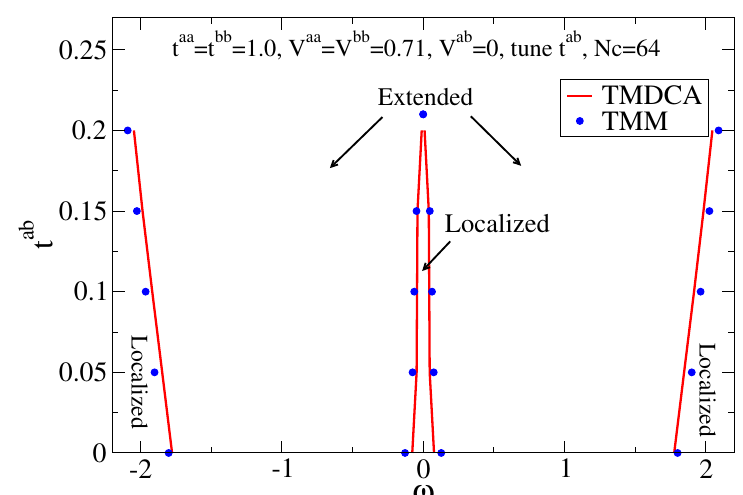
Figure 36. Evolution of the mobility edge of the a-b two-orbital model as t ab increases, while V aa and V bb are fixed. The results are calculated for N c = 64. A dome-like shape shows up around the band center, signaling the closing of the TDOS gap. Reprint from [12].